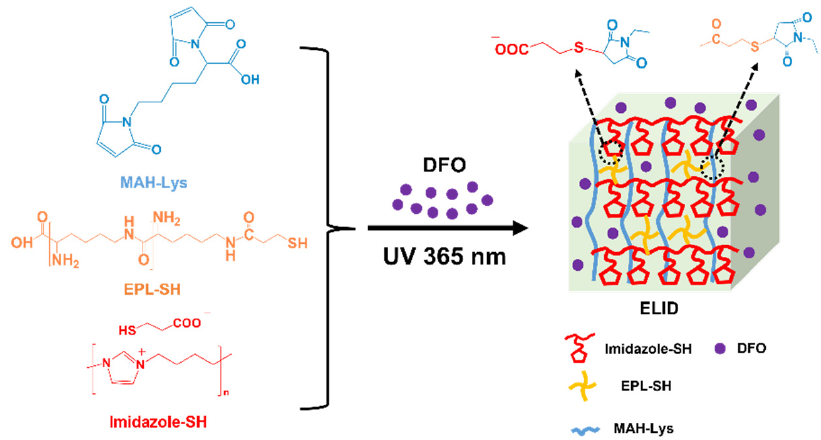
Figure 1. Schematic presentation for the synthesis of ELID hydrogels.